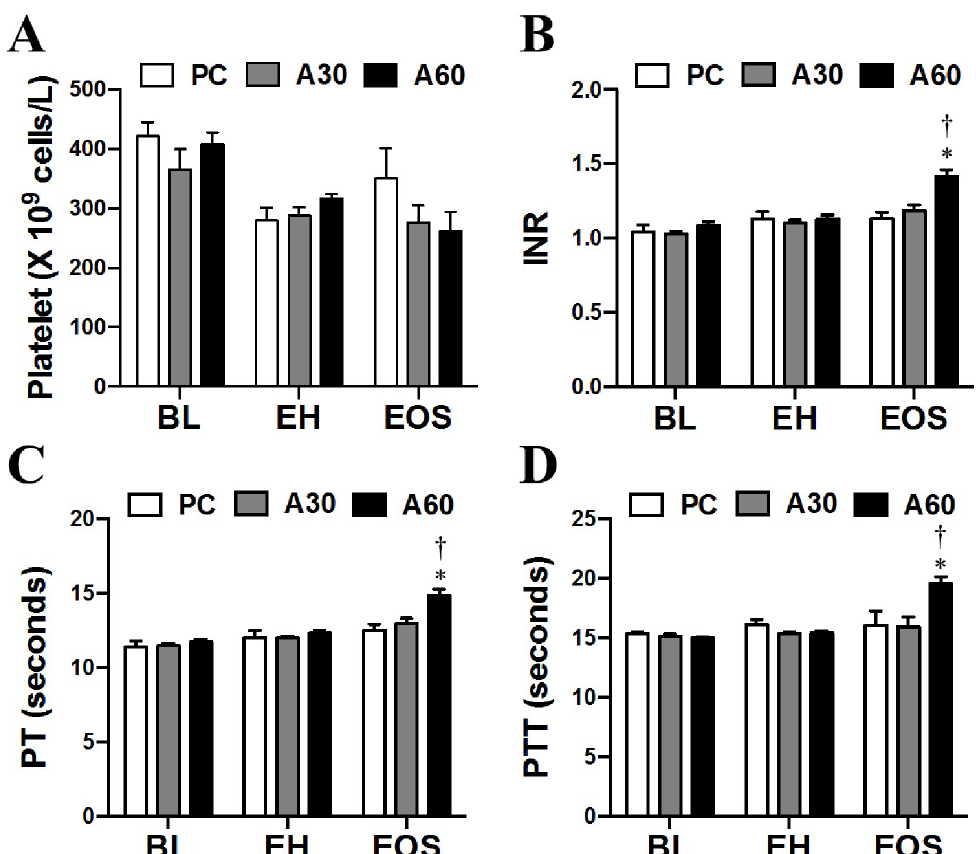
Fig 4. Blood clotting measures in swine undergoing cREBOA. Data are presented as mean ± SEM and were statistically analyzed using two-tailed Mann-Whitney test. � p < 0.05, PC vs . A60 group; † p < 0.05, A60 vs . A30 group. INR, international normalized ratio; PT, prothrombin time; PTT, partial thromboplastin time.